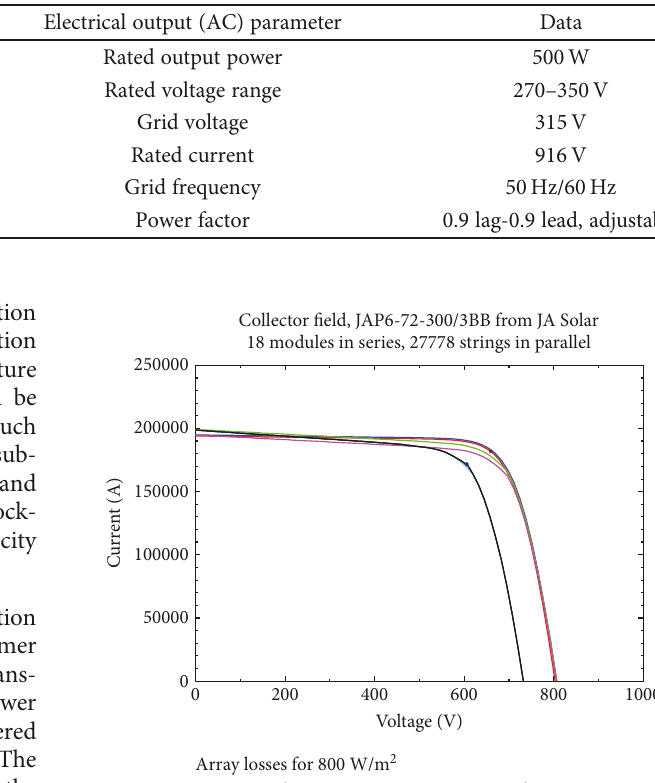
Table 6: Detail of inverter parameters.